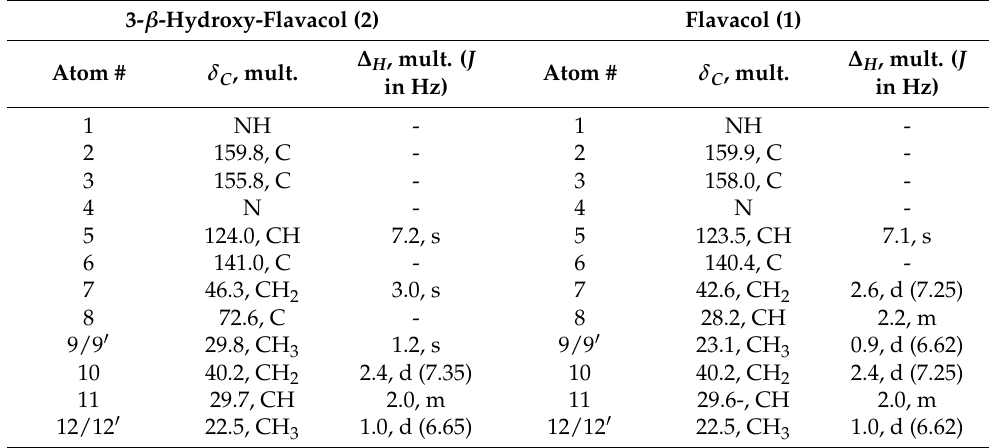
Table 1. NMR data of 3- β -hydroxy flavacol and flavacol (500 MHz in MeOD- d4